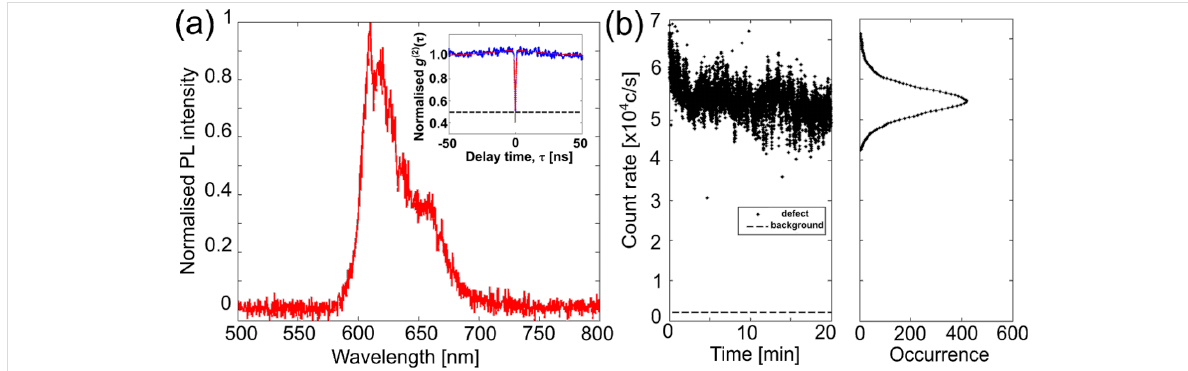
Figure 4: Characterisation results of defect D 1 , shown in Figure 3a, found in the a-450 °C-TiO 2 sample. (a) Normalised PL intensity with an inset of the normalised g (2) data (blue points) with a three-level model fit (red line) at 82 ± 1 μ W pump power. The time bin was 64 ps, with an integration time of 1200 s, the count rates at the detectors was 41.7 × 10 3 and 40 × 10 3 c/s with a background of 2 × 10 3 c/s. The dashed line represents the normalised g (2) ( τ ) = 0.5. (b) The count trace and histogram for 82 μ W pump power. This histogram had the count rate binned into 511 c/s. The back- ground count rate is indicated by the dashed